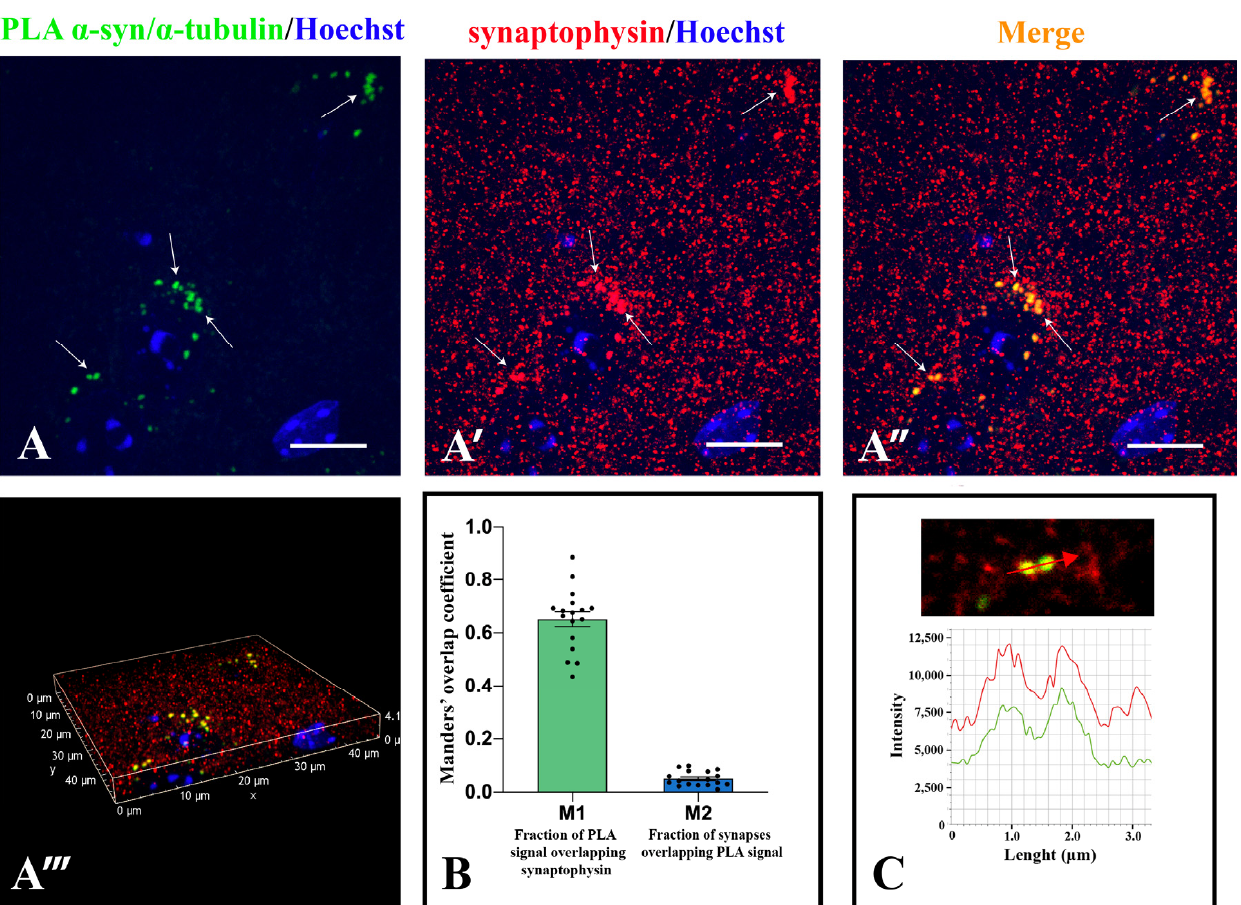
Figure 6. Spinning disk analysis of α -synuclein/ α -tubulin interaction in the synapses of murine corpus striatum . ( A ): Representative maximum projection of α -synuclein/ α -tubulin PLA staining (green, ( A , A” )) and synaptophysin staining (red, ( A’ , A” )) in C57BL/6J mouse corpus striatum . White arrows point to some of the α -synuclein/ α -tubulin PLA signals that colocalize with synaptophysin (yellow dots also in A”’ , C ). Nuclei are counterstained with Hoechst (blue). Scale bars: 5 µ m ( A – A” ). ( A”’ ): 3D reconstruction of all the immunofluorescence signals contained in the tissue slice is showed in the maximum projection. ( B ): M1 and M2 Manders’ overlapping coefficient obtained from 16 images acquired from 4 different mice. ( C ): Intensity profile plot representing the values indicated by the red arrow in the single stack image of the merge channels stained for synaptophysin (red) and α -synuclein/ α -tubulin PLA